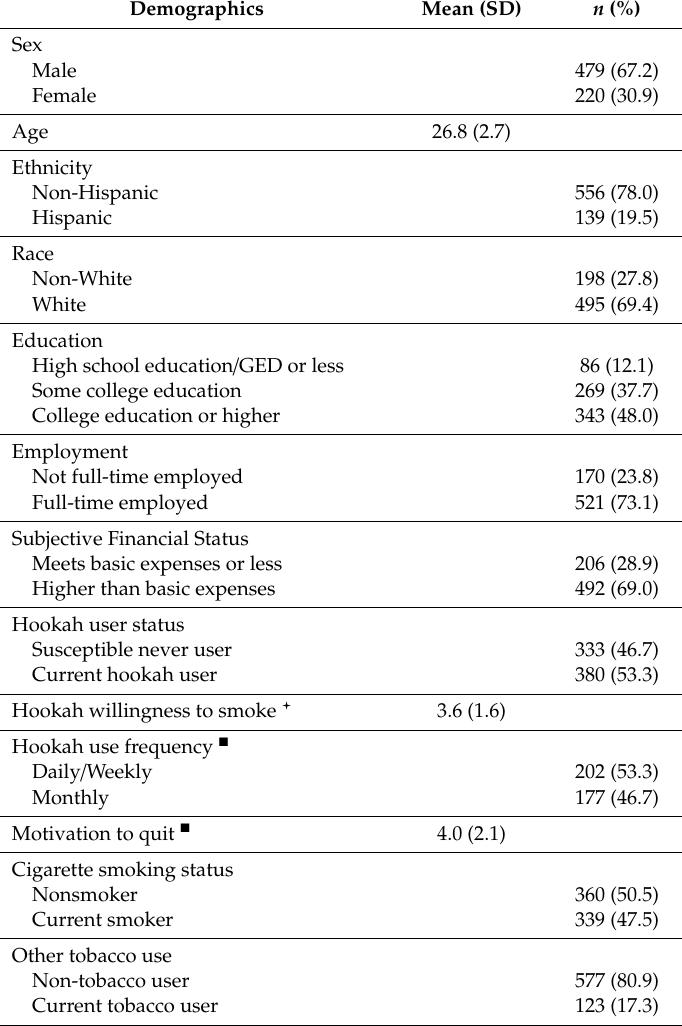
Table 1. Sample characteristics.